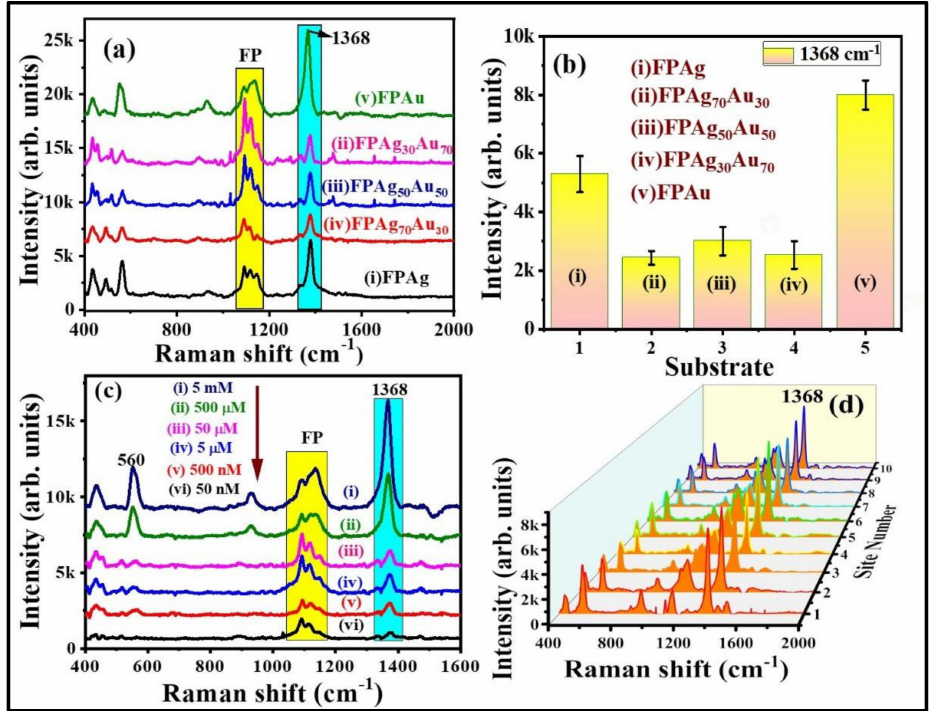
Figure 5c. The SERS peaks intensity decreased upon a decrease of NB concentration. The FPAu substrate had exhibited the lowest detection limit of ~10 − 9 M for NB. Figure S2a illustrates a linear plot between the NB SERS signal intensity versus concentration, and the correlation coefficient (R 2 ) was observed to be ~0.95, demonstrating the detection sensitivity of the FPAu substrate. Further, SERS signal homogeneity of FPAu substrate was examined by recording the Raman spectra of NB (500 µ M) at 15 random sites over the 1 cm 2 area, and the data were presented in Figure S2b. The relative standard deviation (RSD) values for the SERS intensity at 590 cm − 1 and 662 cm − 1 were estimated to be 13.12% and 15.32% acquired from the FPAu substrate. Furthermore, the SERS activity of FP-loaded pure and alloy NPs was investigated with another probe molecule, which was a pesticide (thiram). Figure 6a shows the recorded SERS spectra of thiram (5 mM) from FPAg, FPAg 70 Au 30 , FPAu 50 Ag 50 , FPAg 30 Au 70, and FPAu substrates, respectively. As depicted in Figure 6a, the Raman peak of all SERS spectra were consistent, and they all had a prominent peak at 1368 cm − 1 (CN stretching and symmetric deformation CH 3 ) [46], along with the FP peaks [47], highlighted with blue and yellow boxes, respectively, in Figure 6a. The observed Raman peaks and their assignments of thiram are summarized in Table S2 (Supplementary Materials). The intensity variation in SERS signals acquired from each substrate is presented as a histogram plot in Figure 6b. In the case of thiram also, a prominent SERS effect was noticed from the FPAu substrate as compared to the remaining substrates.